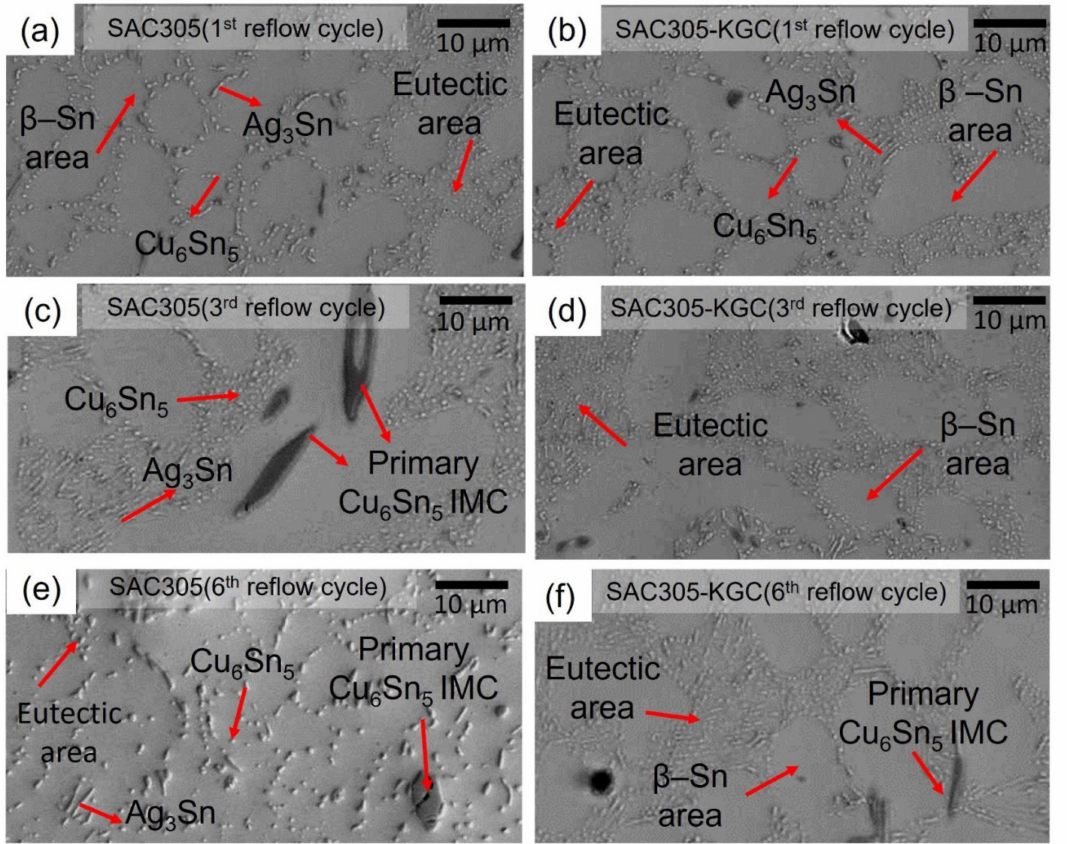
Figure 3. Cross-sectioned microstructure at the bulk solder joints ( a ) SAC305 at 1st reflow cycle, ( b ) SAC305-KGC at 1st reflow cycle, ( c ) SAC305 at 3rd reflow cycle, ( d ) SAC305-KGC at 3rd reflow cycle, ( e ) SAC305 at 6th reflow cycle, and ( f ) SAC305-KGC at 6th reflow